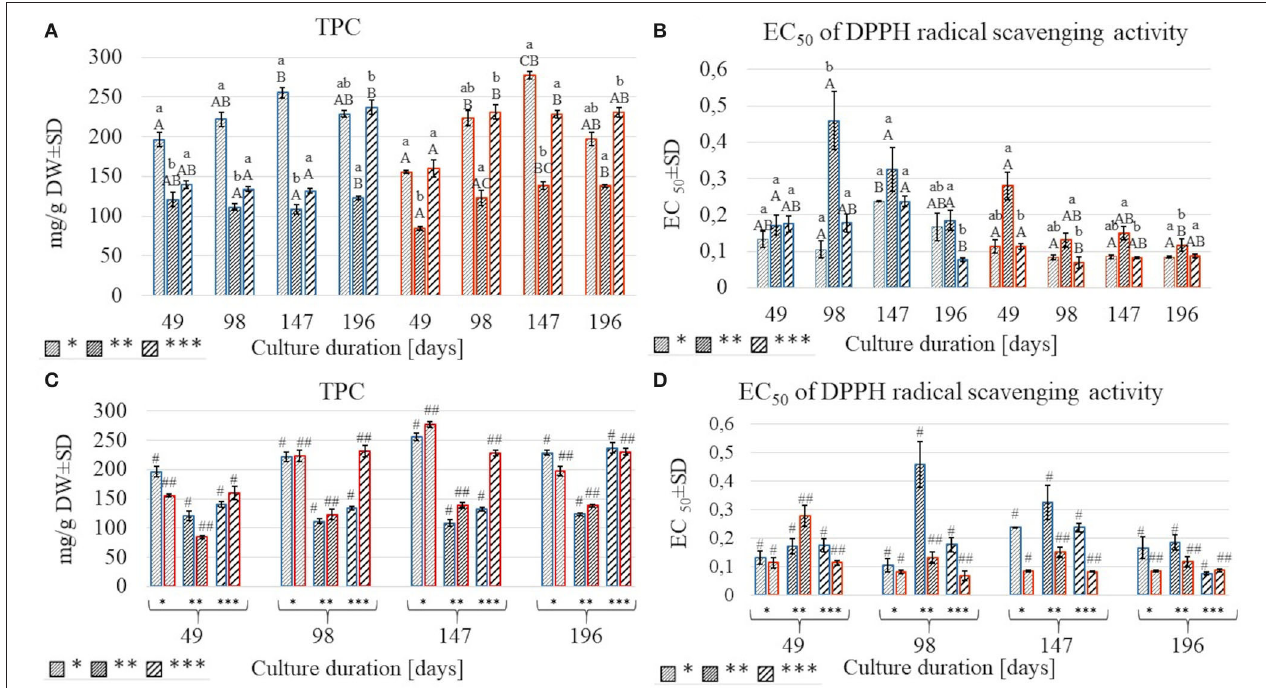
FIGURE 4 | A comparison of total polyphenolic content (TPC) and EC 50 values of DPPH test in S.yangii methanolic extracts from shoots cultured under three light intensities for four culture durations (A,B) and two temperature regimes (C,D) ; LI: *70 µ mol m − 2 s − 1 ; **130 µ mol m − 2 s − 1 ; ***220 µ mol m − 2 s − 1 ; blue: 25 ◦ C, red: 30 ◦ C. Statistical significance of differences was estimated using Kruskal–Wallis test at p < 0.05 and marked with different letters: small letters—differences between samples from three LI; capital letters—differences between samples from four culture durations measured in days; #, ##—differences between samples from two temperature regimes within a single culture duration